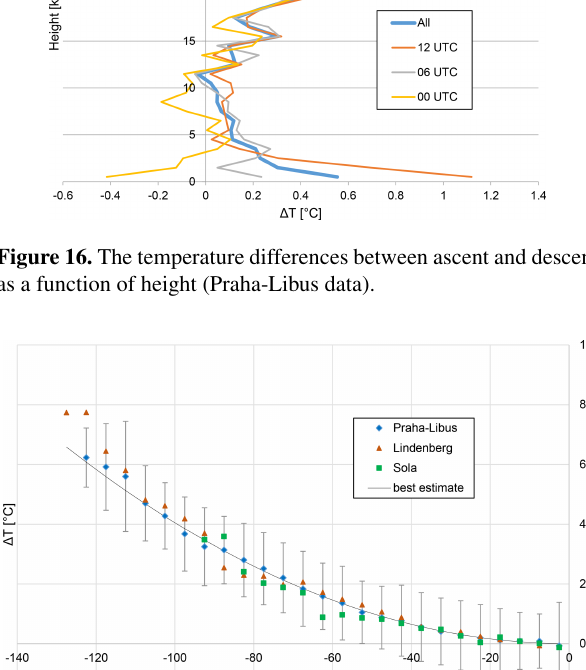
best estimate with A = 4 . 05 × 10 − 4